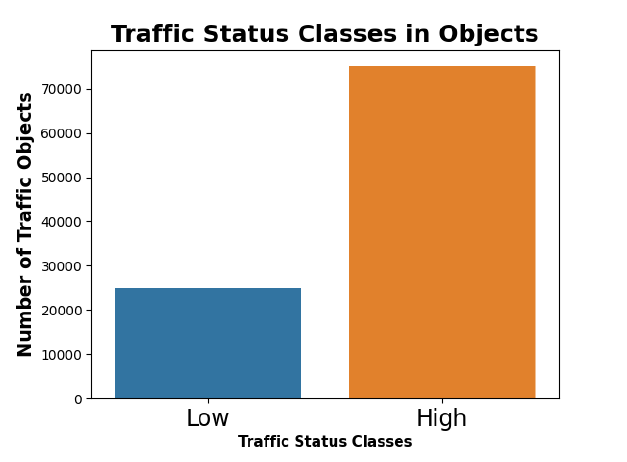
Figure 9. Traffic Status Types.